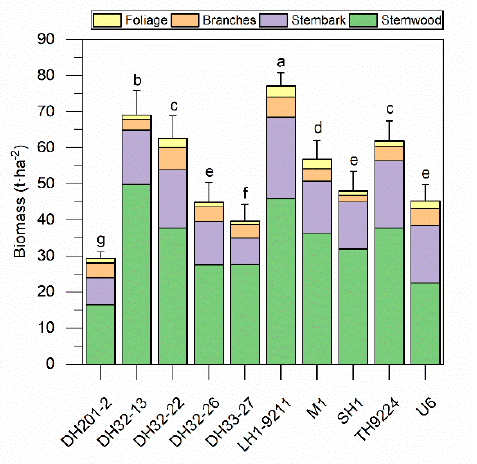
Figure 3. Biomass content of various tree components for ten Eucalyptus Clones. Significant differ- ences within each variable among clones were tested using Tukey’s HSD test (0.05 level); different small letters denote differences in means among clones.